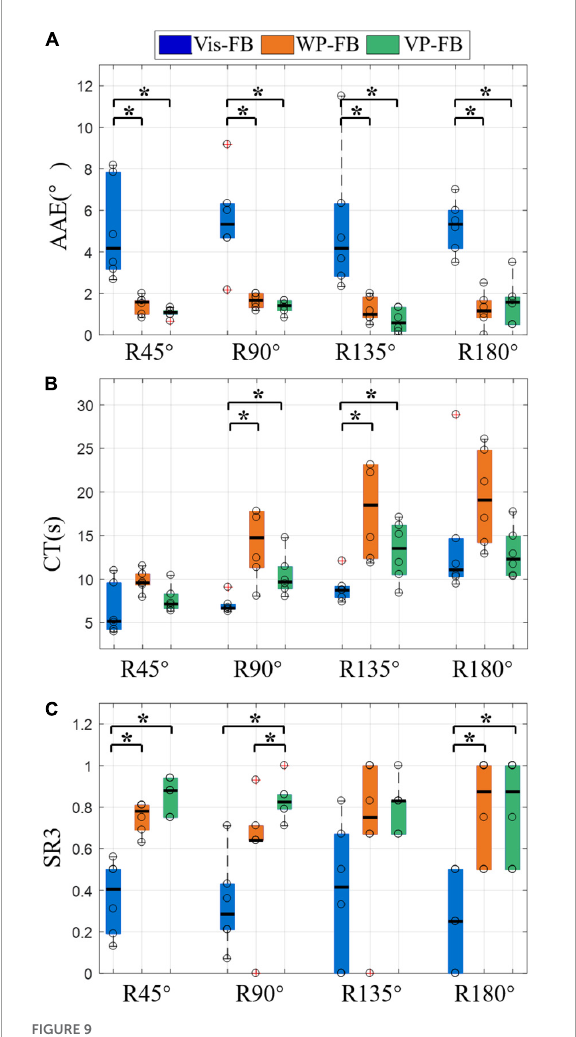
FIGURE9 The results of different rotation angles under three feedback methods, (A) AAE, (B) CT, (C) SR3. Boxplots depict the median ( line ), interquartile range ( box ), maximal/minimal values ( whiskers ), and outliers ( crosses ). The hollow circle denotes the median AAE, CT, and SR3 of each subject in panels (A–C) , respectively. A star denotes the statistically significant differences (* p < 0.05). AAE, absolute angular error; CT, completion time; SR3, success rate when considering the time and angle